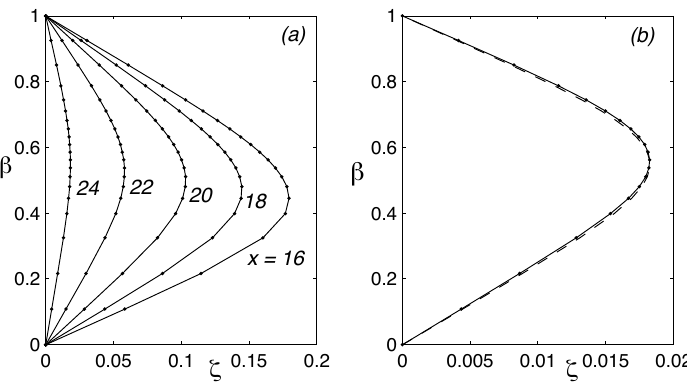
Fig. 10. (a) The vertical structure of the interface displacements, ζ(β) , in the leading rarefaction at the indicated x locations from the numerical solution at t = 30 in Fig. 8. (b) ζ(β) at x = 24 (solid with dots) and the linear eigenfunction scaled to have the same maximum displacement (dashed